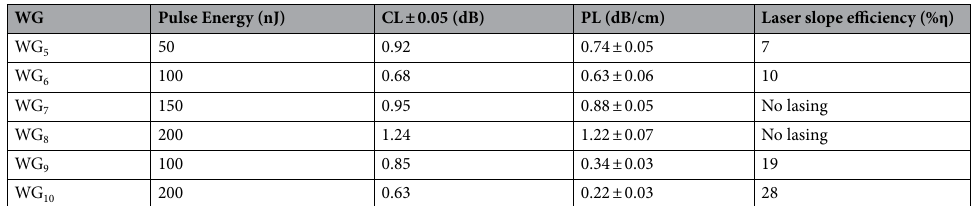
Table 2. CL, PL and laser slope efficiencies in 1 MHz written WGs in Yb 3+ : GPGN glass at 1550 nm. FL for the Yb 3+ :GPGN glass is (0.73 ± 0.05) dB. PL is the WG PL calculated from TL using PL = TL/d where d = 1.05 cm is the length of the